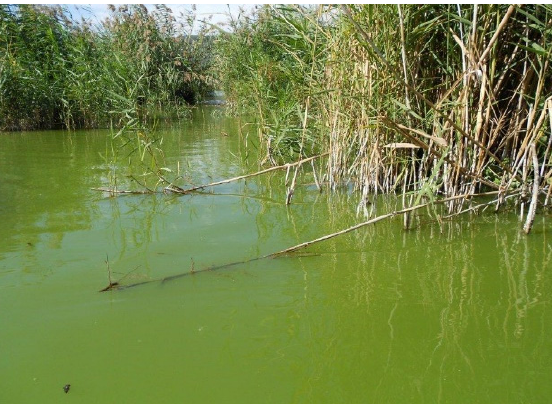
Figure A1. Photos showing the accumulation of surface cyanobacteria scums at the lakeshores of Lesser Prespa in 2014; site II on 4 September 2014 (Panel a ) and 30 October 2014 (Panel b ) and at site III on 10 November 2014 (Panel c ) at Lake Lesser Prespa.